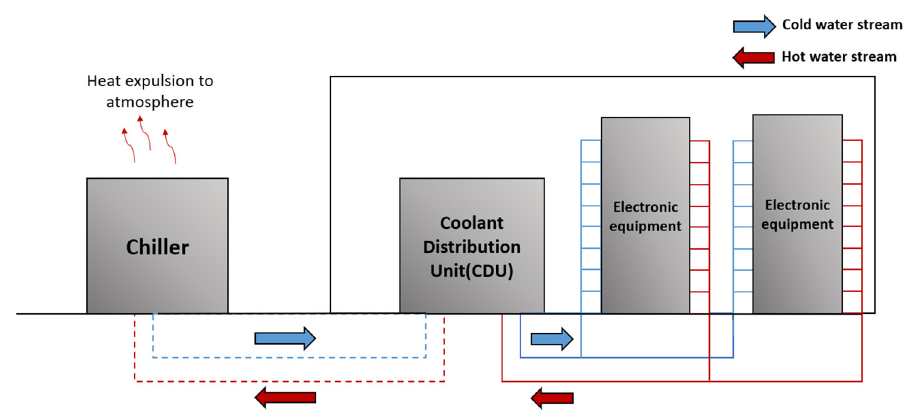
Figure 10. The schematic diagram of indirect water cooling system